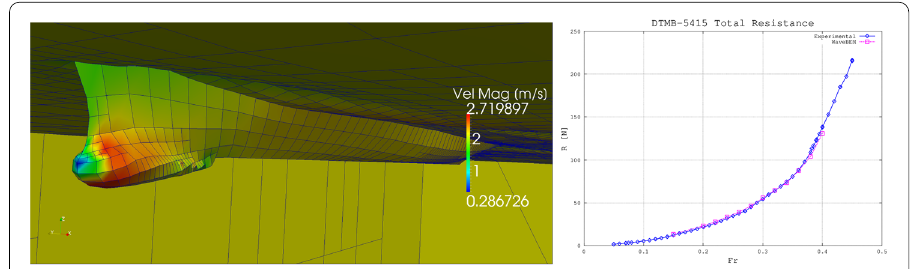
Fig. 7 On the left, the mesh automatically generated on the surface of one of the deformed hulls obtained starting from the DTMB 5415 Navy Combatant Hull. On the right, the total resistance of the DTMB 5415 hull as a function of the Froude number associated with the surge velocity imposed in the simulations. The blue continuous line represents the experimental values presented in Olivieri et al. [33]. The values obtained in this work are represented by the dashed magenta